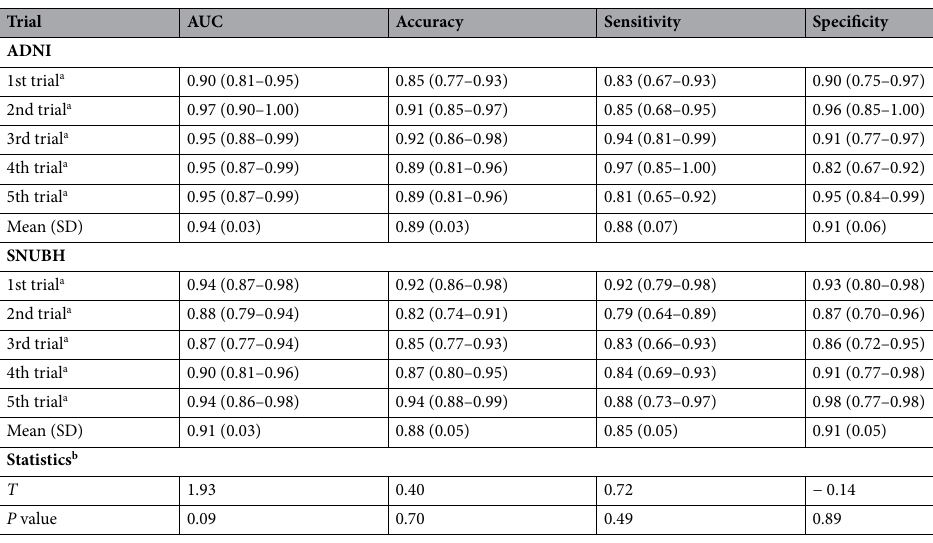
Table 1. Within-dataset testing of AD classification algorithms. AD classification algorithms were developed by randomly selecting 80% of the participants (156 AD patients and 156 CN controls) in each dataset (ADNI and SNUBH) and tested within each dataset on the remaining 20% of the participants (39 AD patients and 39 CN controls). AUC area under the receiver operating characteristic curve, ADNI dataset from the Alzheimer’s Disease Neuroimaging Initiative, SNUBH dataset from the Seoul National University Bundang Hospital, SD standard deviation. a 95% confidence intervals in parentheses. b Comparison of performances on the ADNI and SNUBH datasets using Student’s